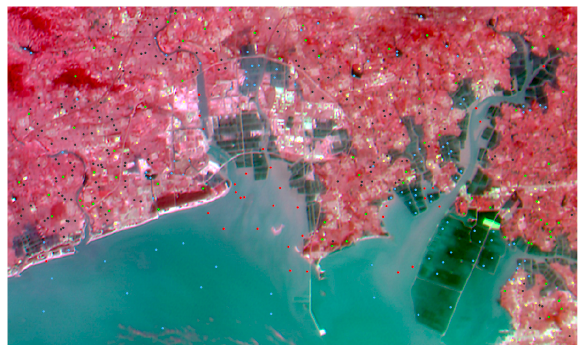
Figure 10. Distribution of the 509 sample points which were selected from the SRR image for Experiment 2 that was obtained using the proposed MSR-NCHOTV algorithm.